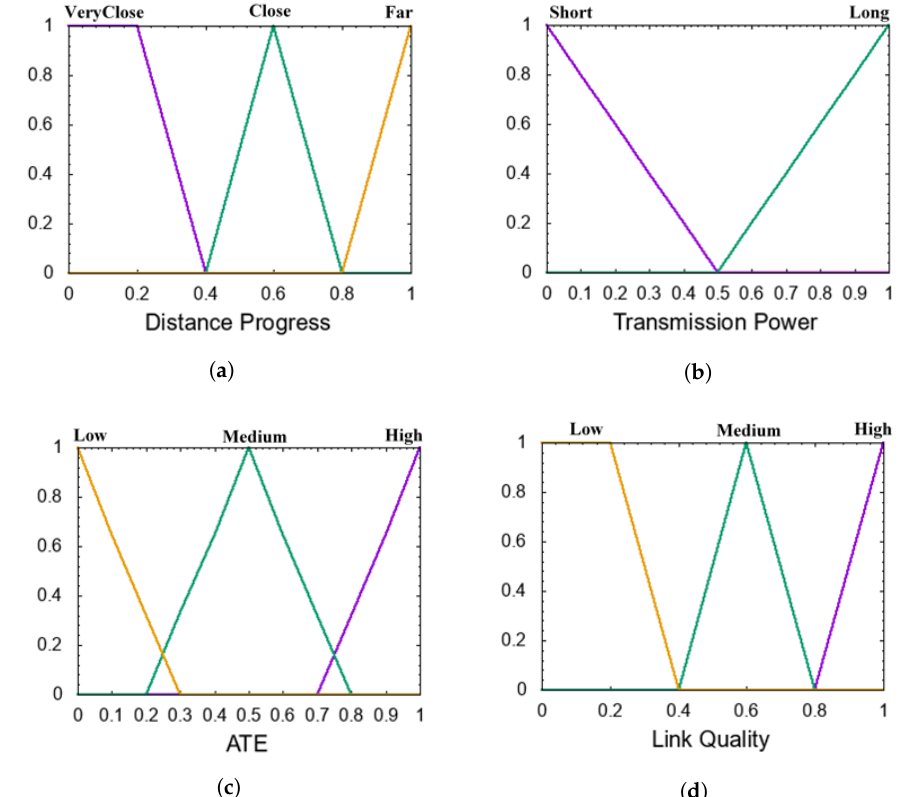
Figure 5. Fuzzy membership functions plots: ( a ) distance progress Fuzzy membership function; ( b ) transmission power Fuzzy membership function; ( c ) ATE Fuzzy membership function; and ( d ) link quality Fuzzy membership